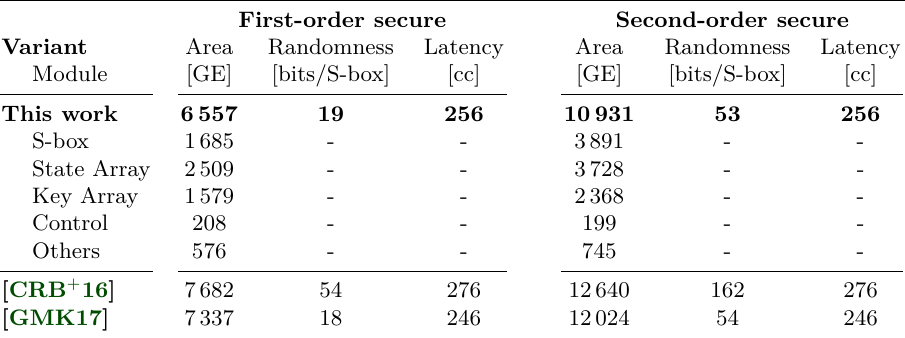
Table 5: Implementation results for AES-128 with Nangate 45nm